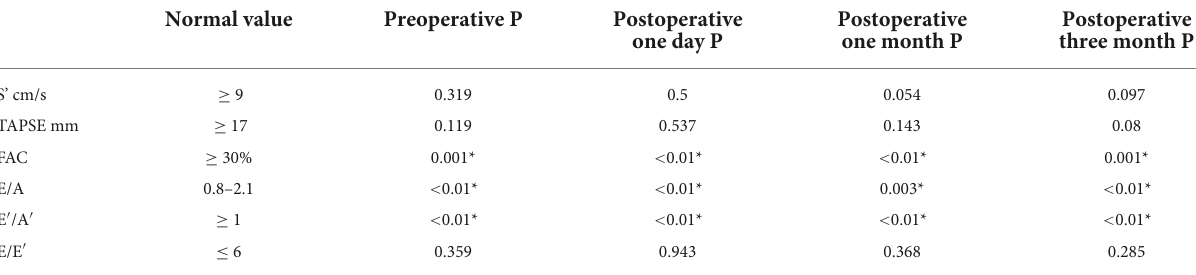
TABLE 7 Echocardiographic parameters about right ventricular